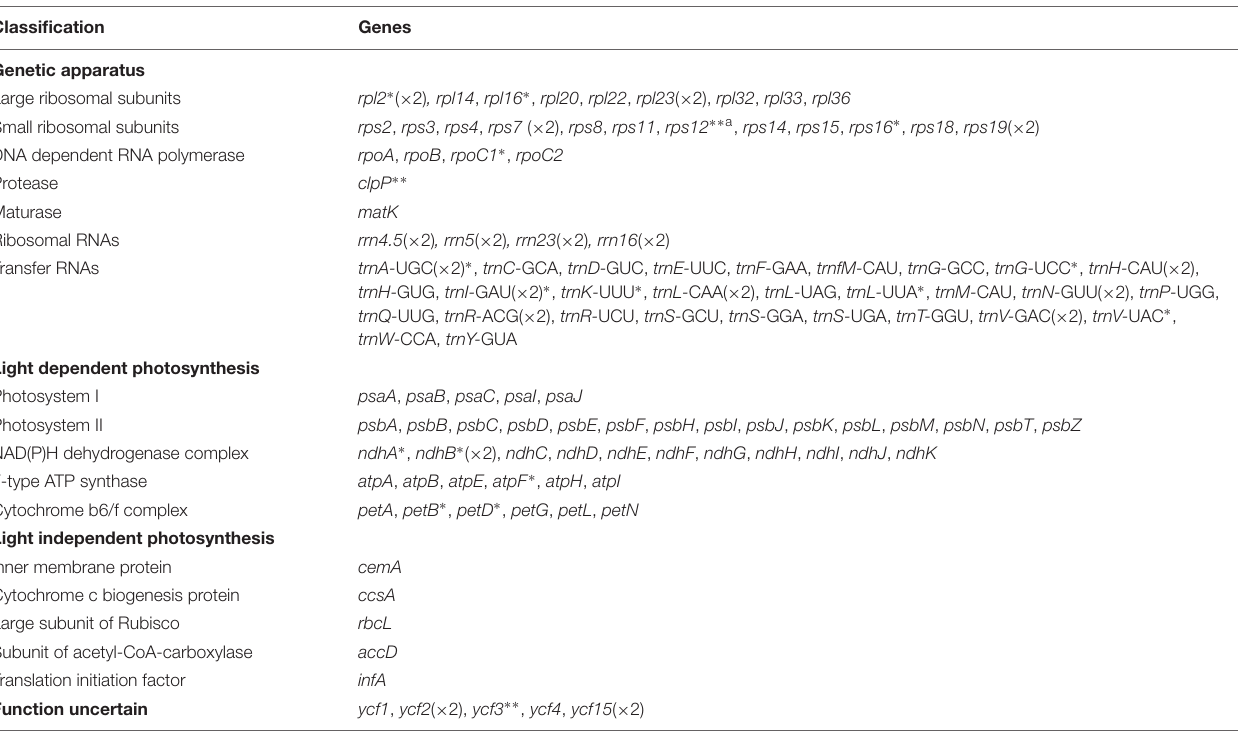
TABLE 2 | Gene contents in four Echinacanthus species chloroplast genome. Classification Genes Genetic